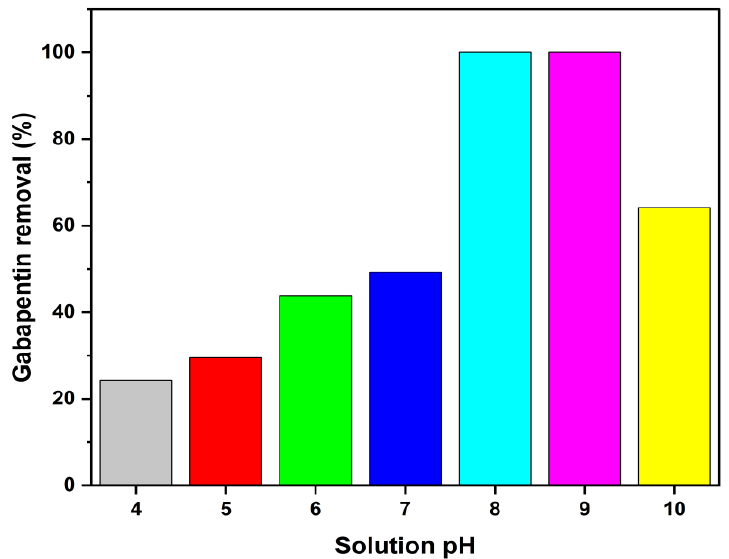
Figure 6. Effect of solution pH on GBP degradation in the Cu-TiO 2 -UVA system (GBP = 10 mg/L, catalyst = 0.5 g/L, reaction time = 20 min).